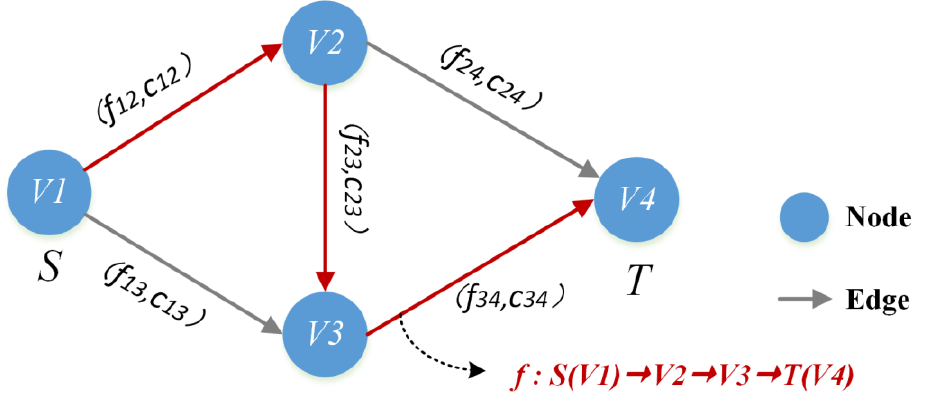
Figure 2. Definition of maximum flow model.